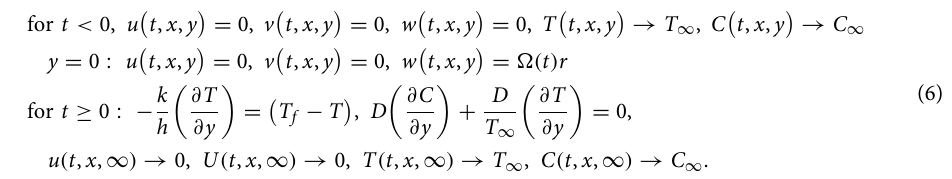
Initial and boundary conditions. Subject to the corresponding initial and boundary condition 30